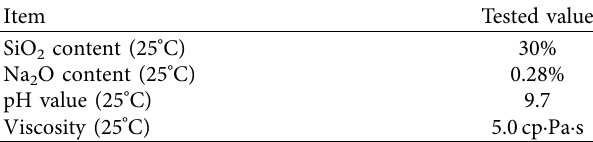
Table 1: Parameters of nanosilica sol